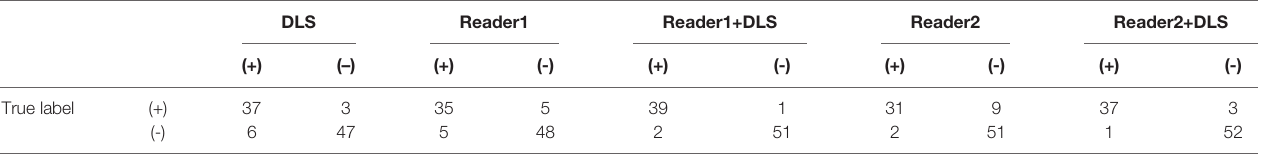
TABLE 1 | Classi fi cation results for the testing